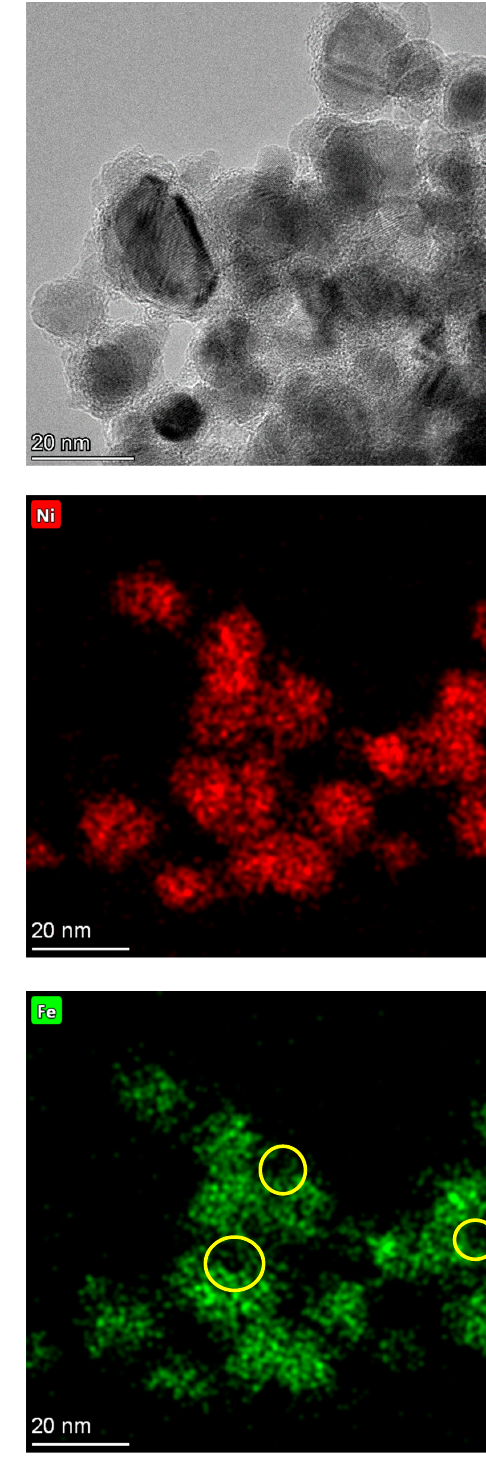
Figure A10. TEM micrographs and elemental maps of the fresh ( left ) and spent ( right ) Fe-promoted catalysts showing both the formation of large particles during catalyst aging and the degree of association between Ni and Fe in the fresh and spent formulations. Note that micrographs and elemental maps correspond to different regions. The yellow circles on the bottom micrographs denote the Fe-hollow spaces.